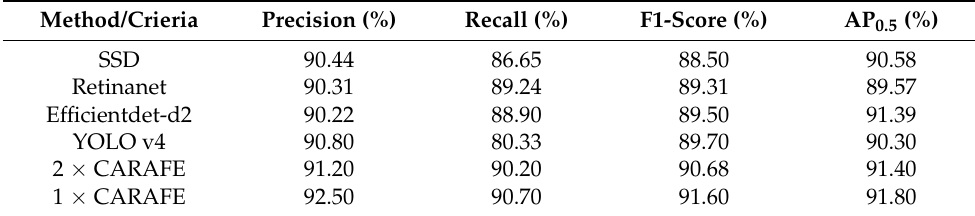
Table 6. Comparison of carafe experiment.